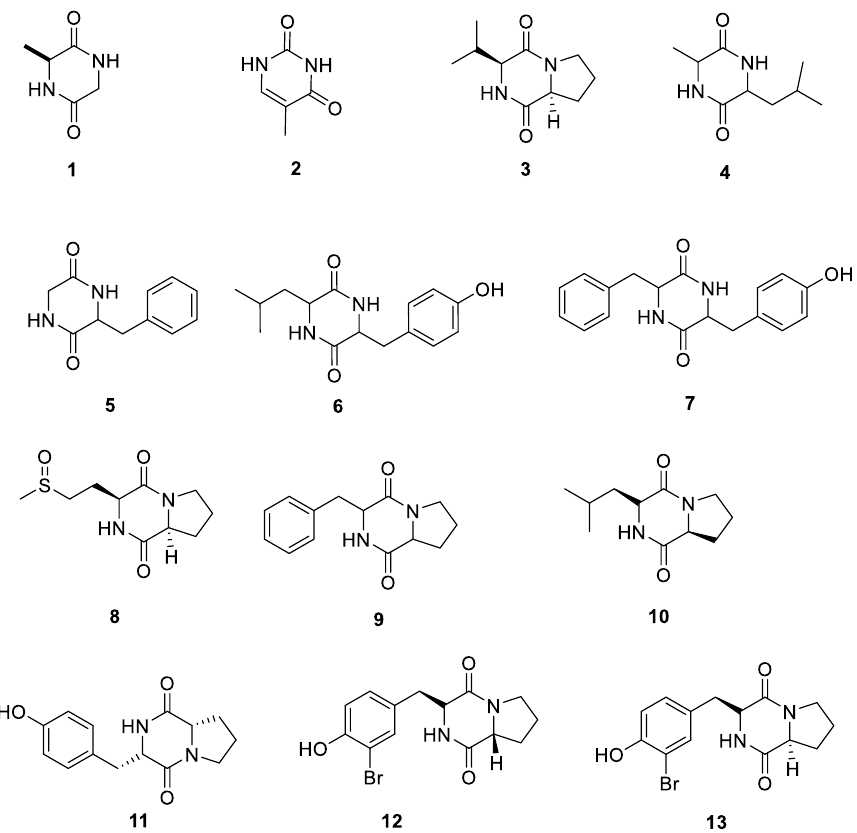
Figure 3. Chemical structures of compounds 1 − 13 from lichen-associated actinomycetota. Antipain ( 16 ), V2 (antipain dehydration product) ( 17 ), and lichostatinal ( 18 ) were isolated from a British Columbian lichen associated with Streptomycetes sp . L91-3 [39]. Compound 16 was a known potent cathepsin K (CatK) inhibitor, whereas 17 was a new dehydrated analog of antipain and a much weaker CatK inhibitor. Compound 18 was identified as a new potent CatK inhibitor using affinity crystallography. N - methyldactinomycin ( 19 ) was collected from Streptomyces cyaneofuscatus MOLA1488 from Erquy (France) [36]. Geninthiocin B ( 20 ) was isolated from Streptomyces sp. YIM 130001 obtained from the tropical rainforest in Xishuangbanna (Yunnan, China). It showed antibacterial activity against Bacillus subtilis [28]. Skyllamycins A − E ( 21 − 25 ) were isolated from a Streptomyces anulatus strain from the New Zealand lichen Pseudocyphellaria dissimilis . Antibacterial assays revealed that compound 24 possessed superior activity against B. subtilis E168 compared to previously reported congeners [40]. All 12 PNPs from the lichen derived actinomycetota described above are presented in Figure 4.